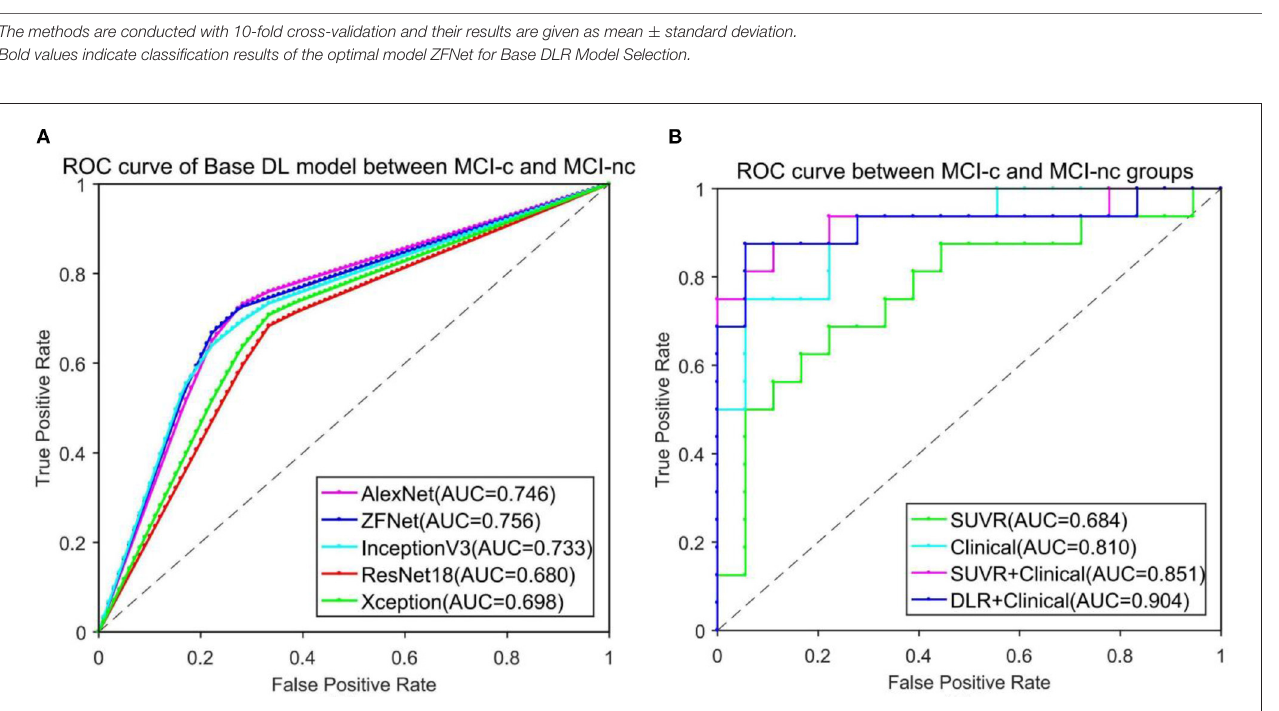
FIGURE 3 | ROC curve comparison in classification of MCI-c and MCI-nc. (A) ROC curve of five different Base DL pre-training models. (B) ROC curve of four different comparative